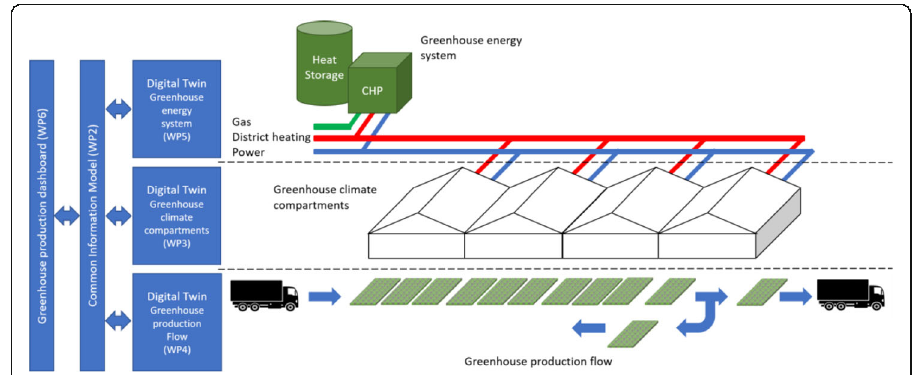
Fig. 1 Greenhouse Industry 4.0 Project